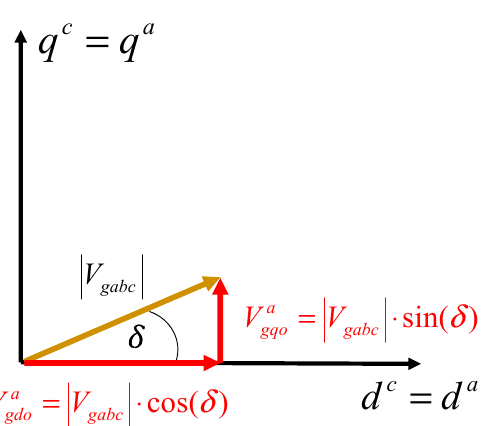
Figure 4. Projection of the grid voltage into the converter dq reference frame.